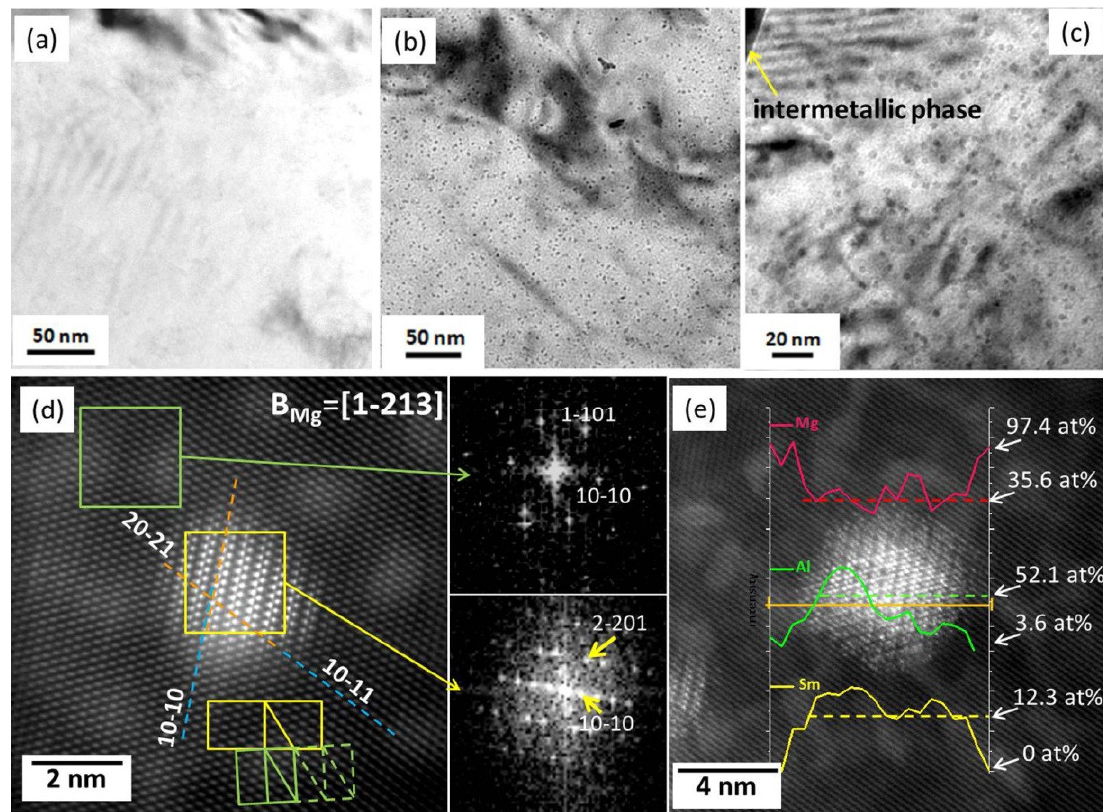
Figure 8. ( a – e ) TEM and atomic-resolution STEM images showing precipitates in ASm46 alloy [87].